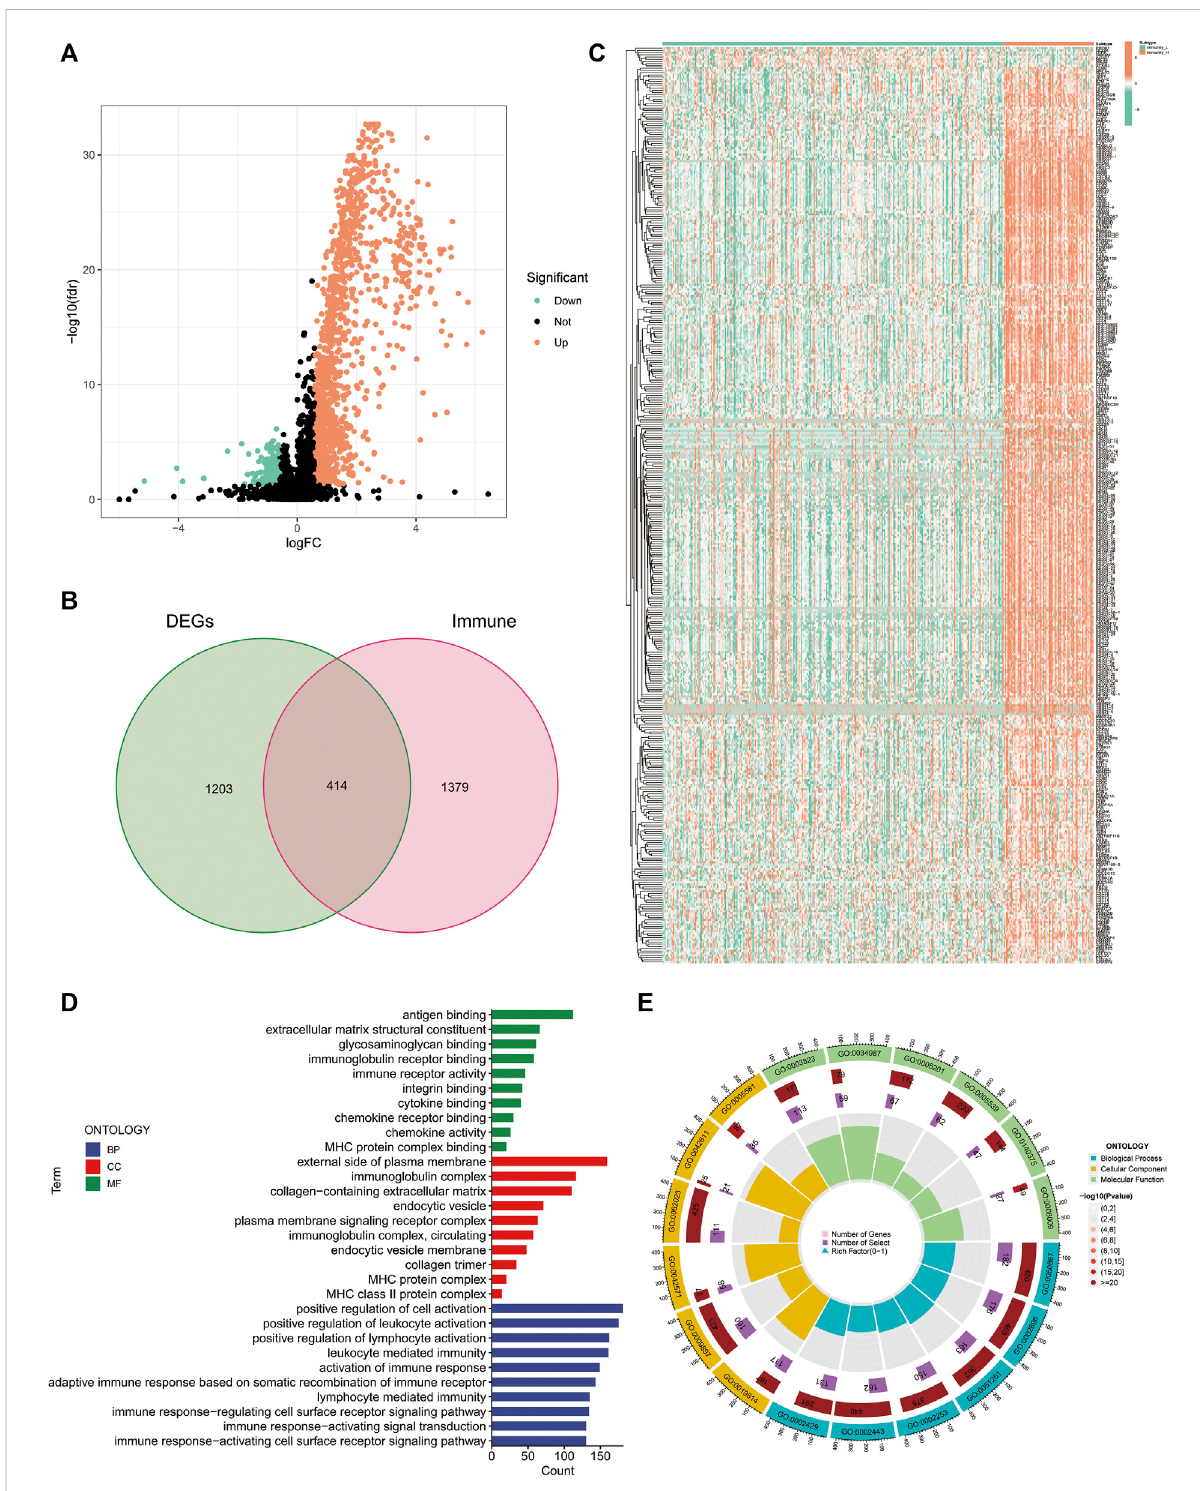
FIGURE 2 Differentially expressed genes between the high and low-immune clusters. (A) Volcano map of differentially expressed genes between the high- and low-immune clusters. (B) The Venn diagram shows the 414 intersecting genes that were obtained after intersecting the differentially expressed genes and immune-related genes. (C) Heat map of the expression of 414 intersecting genes in different immune clusters. (D,E) Enrichment of differentially expressed genes between the high- and low-immune clusters in terms of biological function via GO